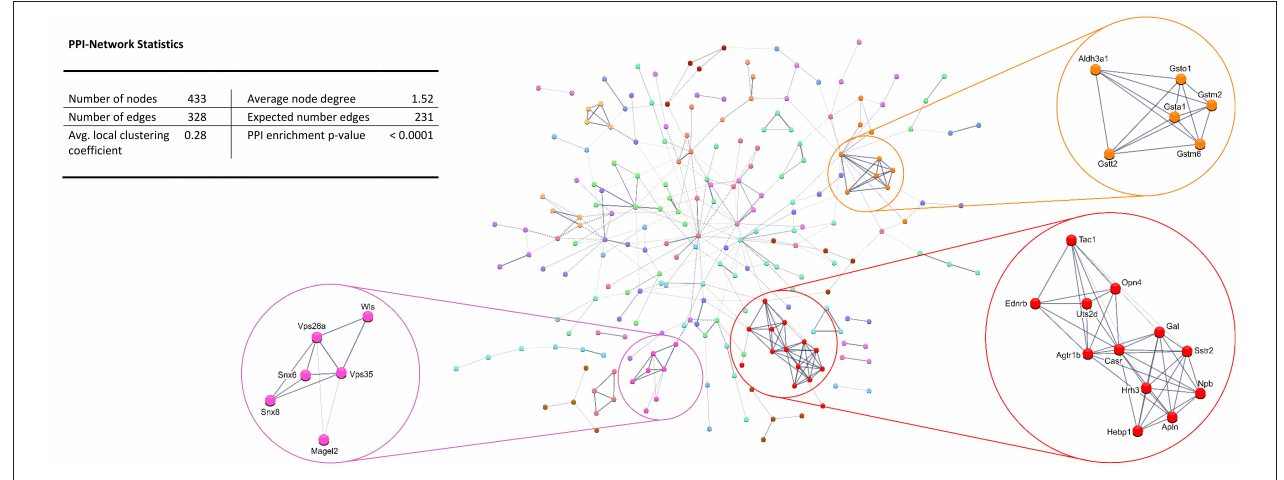
FIGURE 3 | STRING database protein-protein interaction (PPI) network of significantly upregulated genes. Cut-off values, p ≤ 0.01, fold change ≥ 1.2.